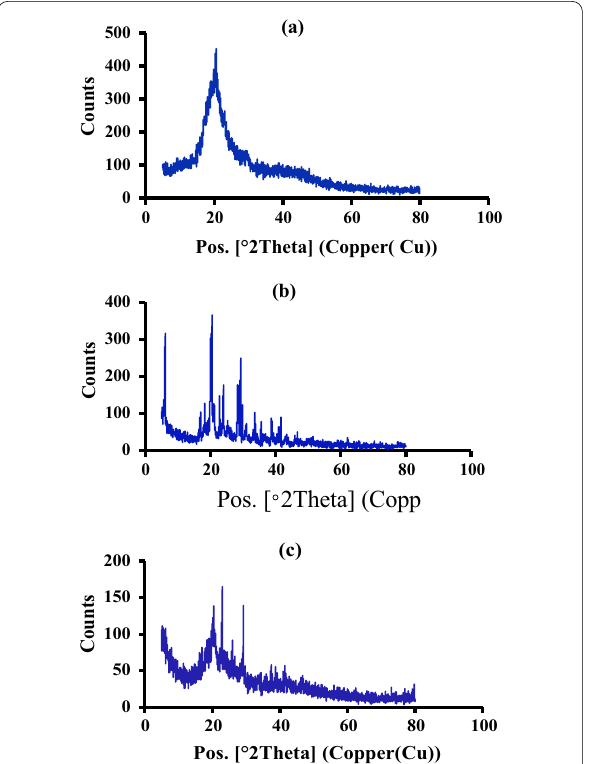
Fig. 2 XRD pattern of copolymer ( a ), aniline graft ( b ) and 2‑chloroaniline graft ( c )